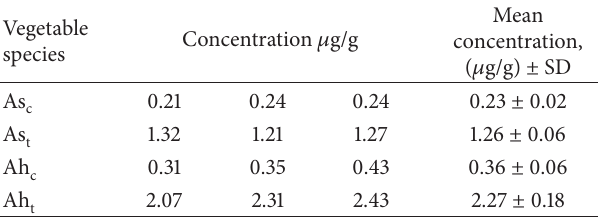
Table 4: Selenium concentrations observed for Amaranthus